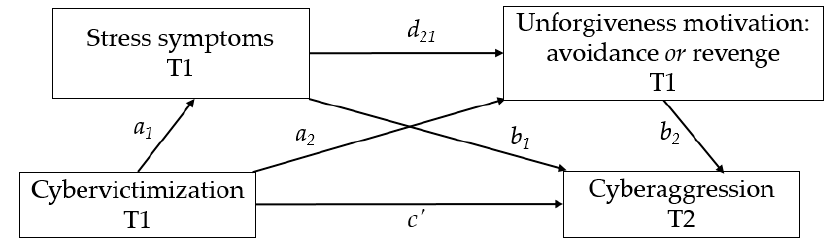
Figure 1. Proposed serial mediation model linking cybervictimization to cyberbullying aggression through stress and unforgiveness motivations (i.e., avoidance or revenge) as serial mediators. Note: a , b , c , c ′ , and d represent path coefficients.